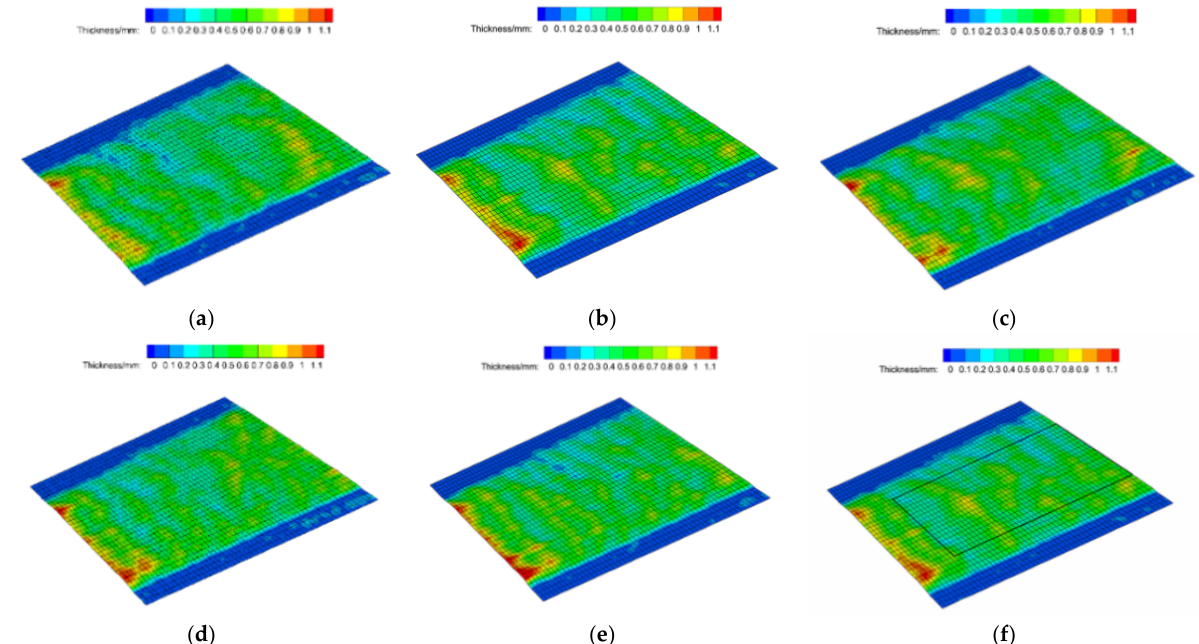
Figure 5. Instantaneous image and data processing range: ( a ) t = 0 s; ( b ) t = 0.2 s; ( c ) t = 0.4 s; ( d ) t = 0.6 s; ( e ) t = 0.8 s; ( f ) Data processing